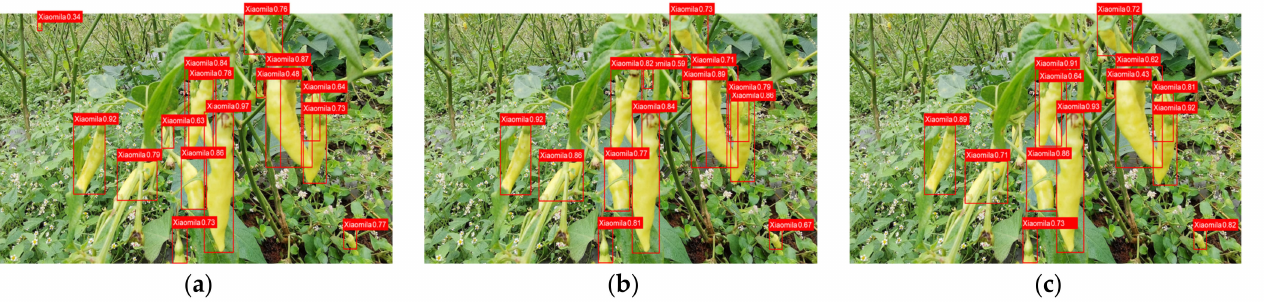
Figure 13. Comparison of the detection results of different models when large and small objects are alternately distributed. ( a ) YOLOv5s-CFL detected many unlabeled small targets; ( b ) YOLOv5s detected few unlabeled small targets but missed one fruit covered by other fruit; ( c ) YOLOv3-tiny did not find small targets.